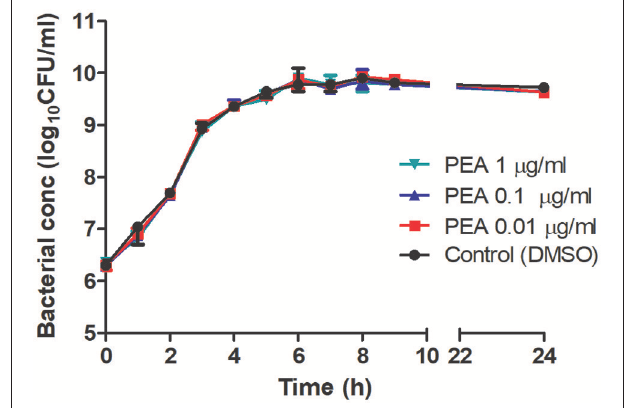
FIGURE 3 | Growth curves of E. coli K1 in brain heart infusion in the presence of different concentrations of PEA and control medium without PEA (0.17% DMSO). At different time points, serial dilutions were plated on blood agar and viable bacteria (CFU/ml) were quantified after overnight incubation. Data are presented as median ± range ( n =